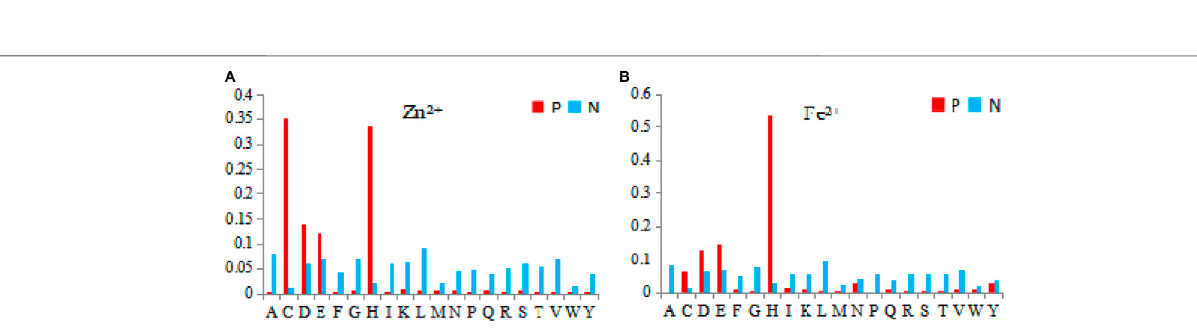
FIGURE 4 | The probability difference of the thirdly neighbor correlation of Fe 3+ positive and negative fragments. Note: the abscissa 1 – 400 is AA, AC, AD, ... , AY, CA, CC, CD, ... , CY, ... , YA, YC, YD, ... , YY. The ordinate is the D-values of the positive sets minus the negative sets.